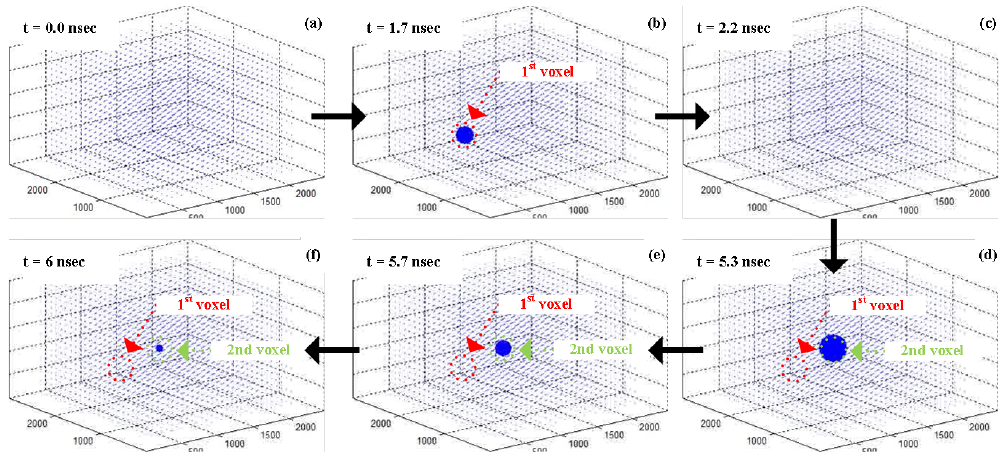
Figure 16. Example snap-shot frames for reconstructing the fluorophores.